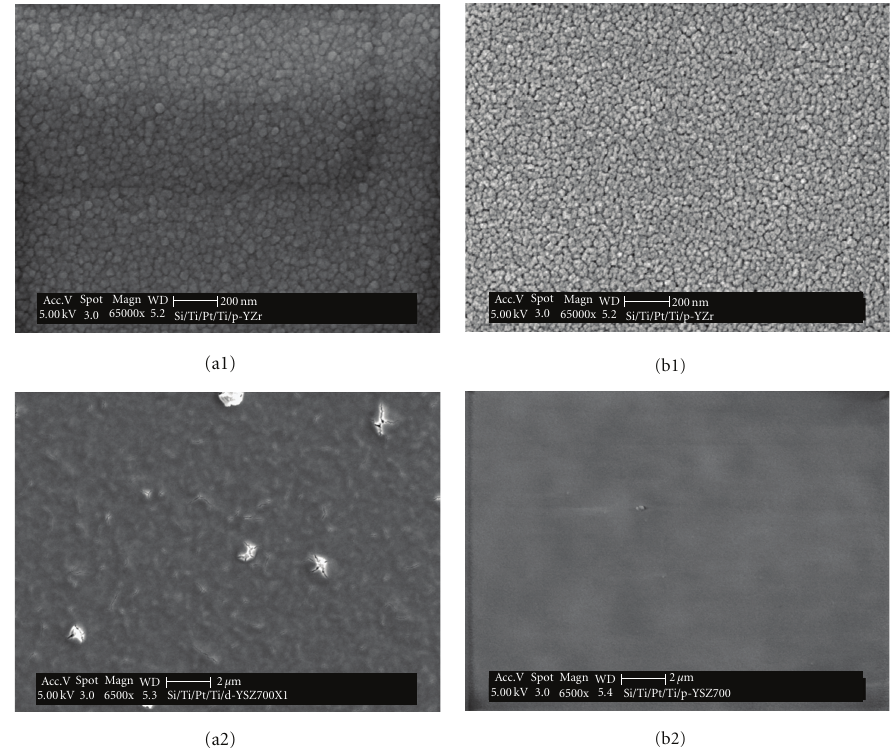
Figure 3: SEM images of (a1) dense Y/Zr film deposited at 0.5Pa; (b1) less dense Y/Zr thin films deposited at 2Pa; (a2) YSZ thin films oxidized from (a); (b2) YSZ thin films oxidized from (b). The substrate is Si wafer. Oxidation condition is 800 ◦ C for